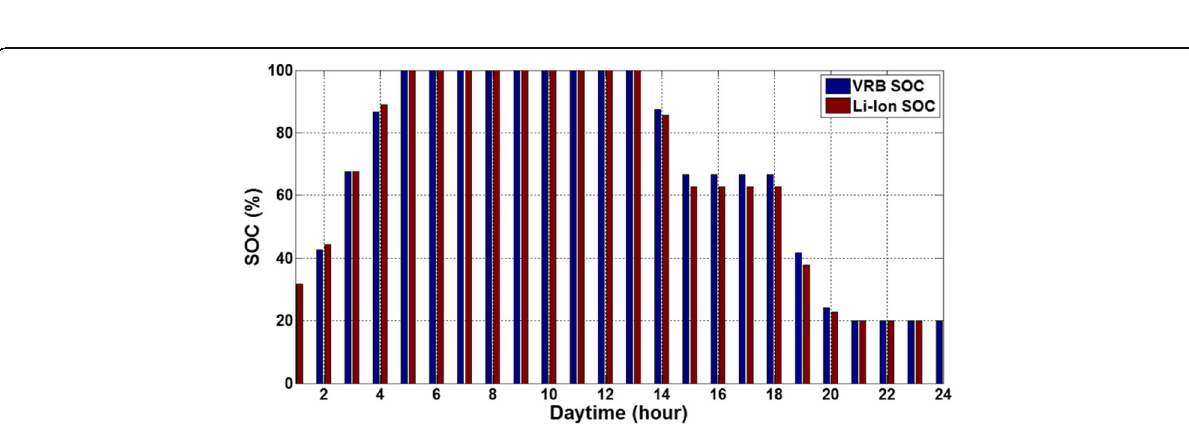
Fig. 12 SOCs of VRB and Li-Ion battery obtained using RegPSO in non-isolated operation